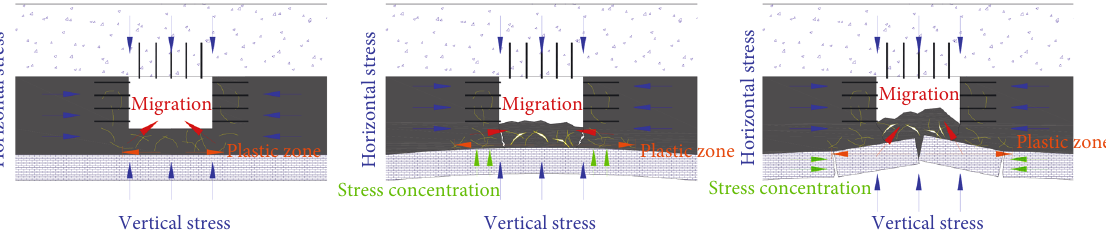
Figure 5: Migration evolution of fl oor-surrounding